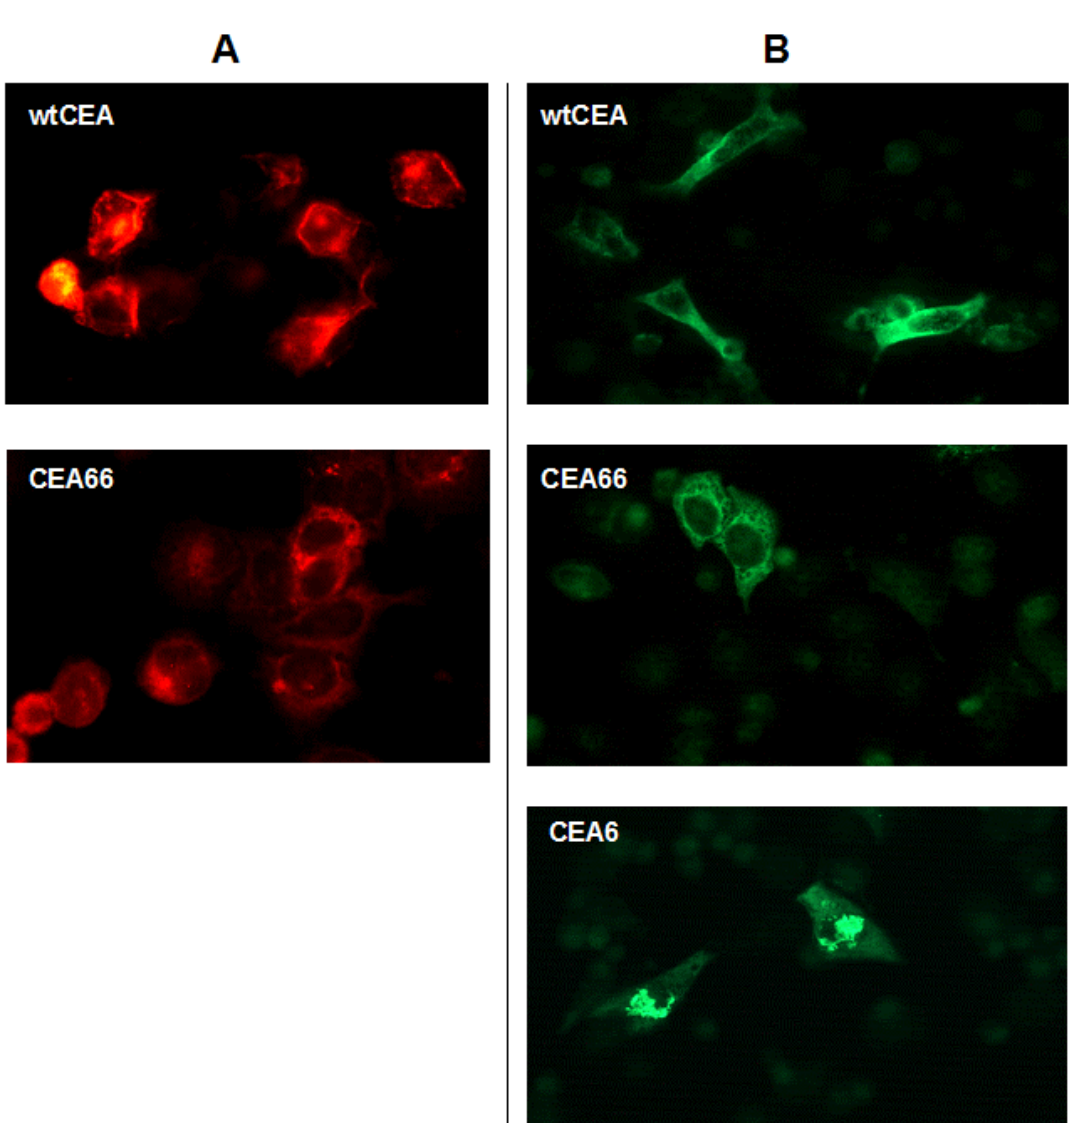
FIGURE 2. Deletion of signal peptides alters the cellular localization of CEA . HeLa cells, transiently transfected with different CEA constructs, were fixed and permeabilized in acetone:methanol (80:20%), and stained with: (A) a mixture of mouse monoclonal antibodies (DAKO clone II-7 1:10, Col-1 1:15, and 1C11 1:15) and visualized with TRITC-labeled goat antimouse IgG; (B) rabbit antihuman CEA followed by a FITC-labeled swine antirabbit